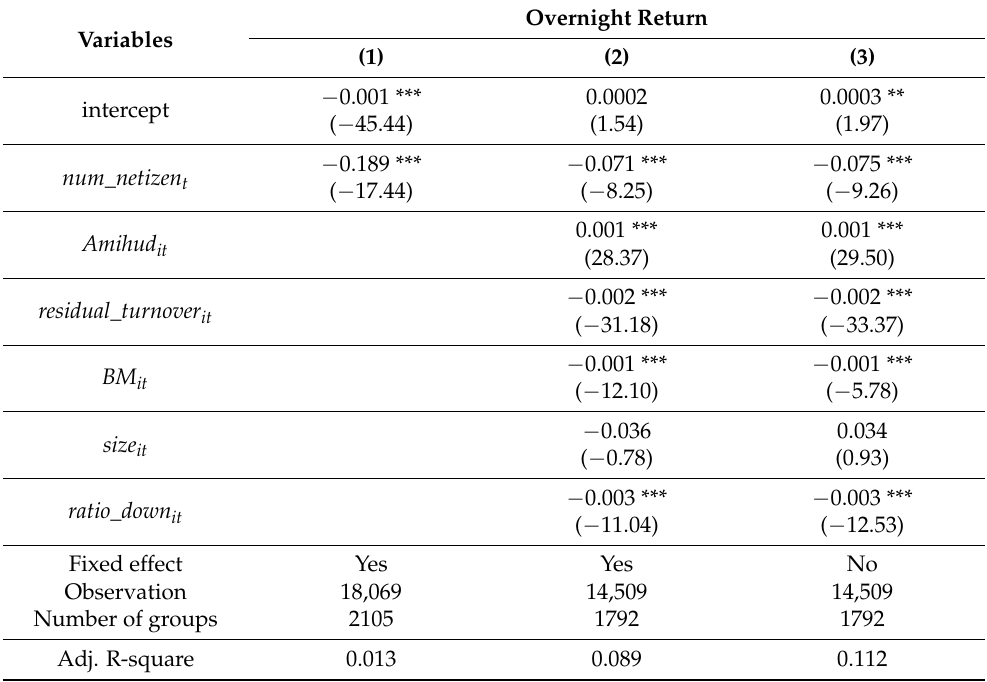
Table 11. Panel regression of overnight return against number of internet users. This table presents the results of the panel regression of the overnight return against the number of internet users ( num_netizen t ). Column (1) is a univariate test. Columns (2) and (3) are panel regressions with and without fixed effects, respectively. The turnover ( residual_turnover it ) is obtained following an orthogonal process to eliminate its liquidity component (using the Amihud illiquidity) to serve as a proxy for investor